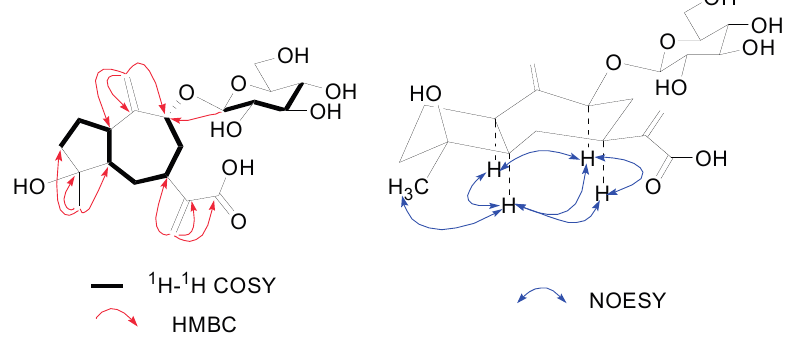
Figure 4. Key 1 H- 1 H COSY, HMBC and NOESY correlations of 3